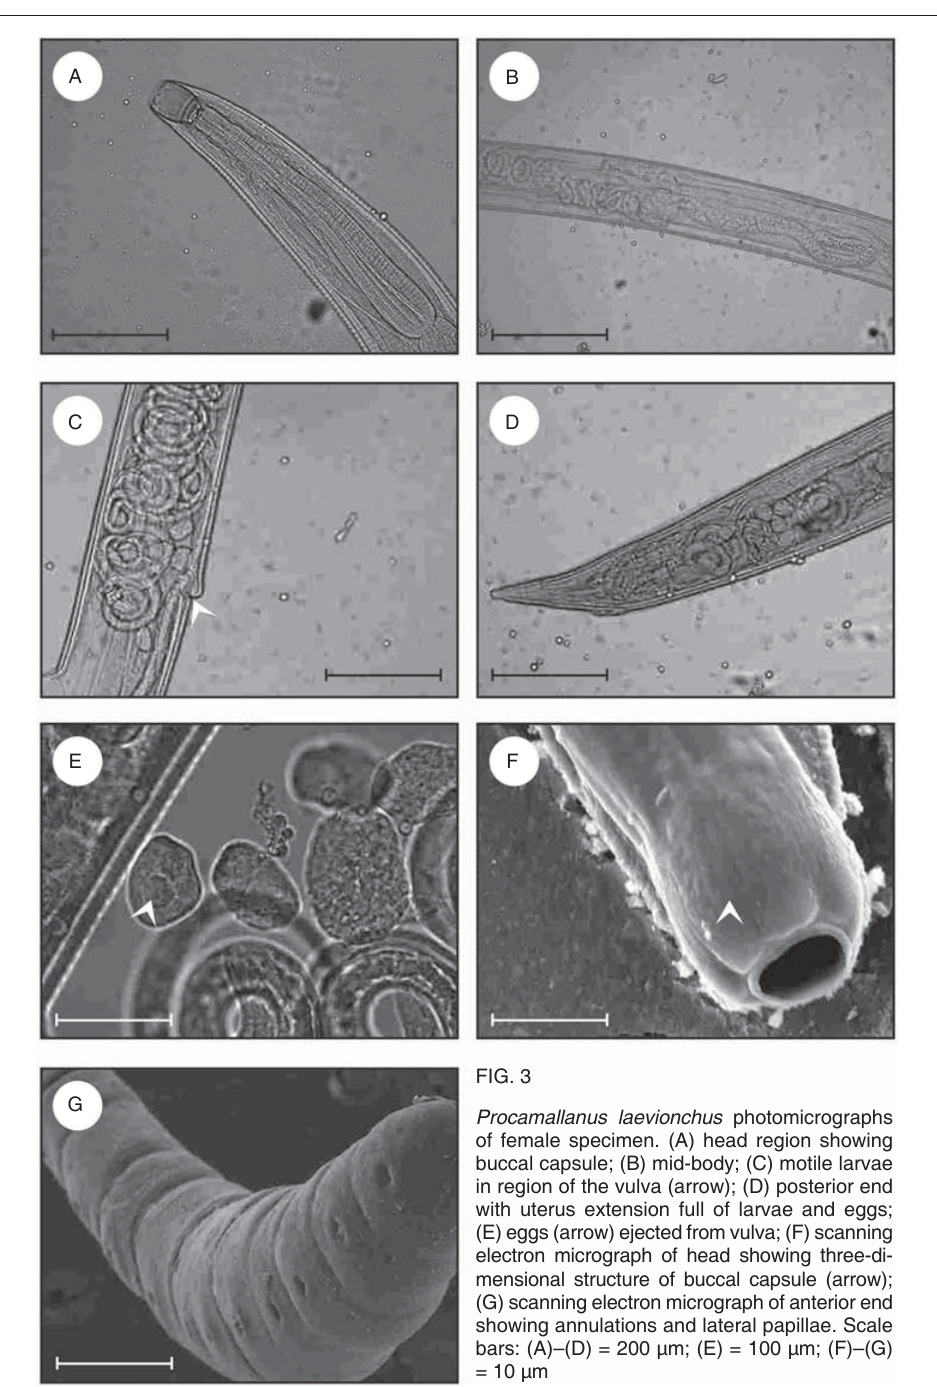
FIG. 3 Procamallanus laevionchus photomicro graphs of female specimen. (A) head region showing buccal capsule; (B) mid-body; (C) motile larvae in region of the vulva (arrow); (D) posterior end with uterus extension full of larvae and eggs; (E) eggs (arrow) ejected from vulva; (F) scanning electron micrograph of head showing three-di- mensional structure of buccal capsule (arrow); (G) scanning electron micrograph of anterior end showing annulations and lateral papillae.